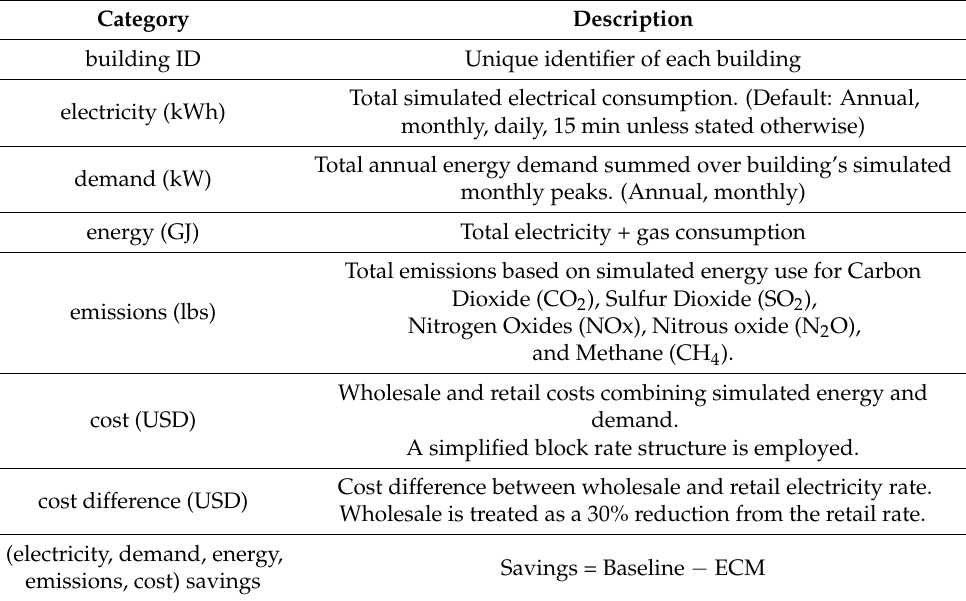
Table 3. Consolidated simulation outputs calculated for each measure. Acronym: ECM (Energy Conservation